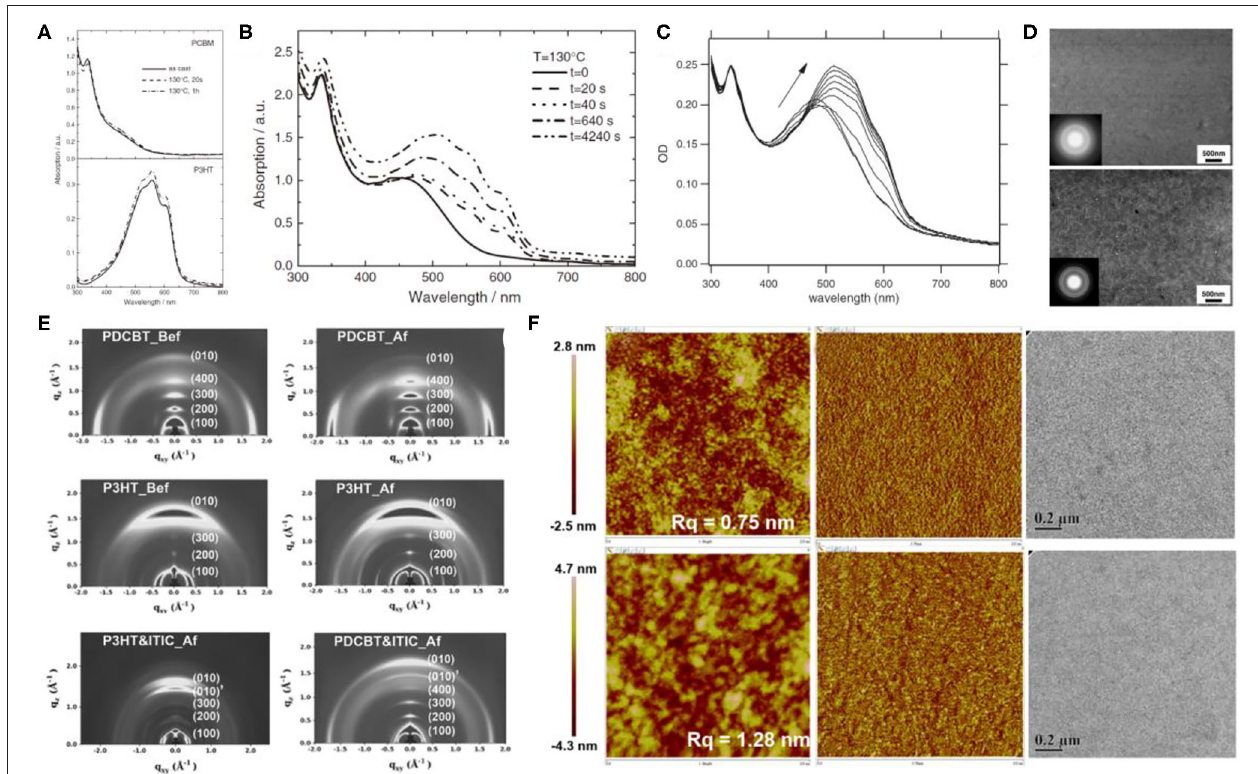
FIGURE 4 | (A) Absorption spectra of pure PCBM (top) and P3HT (bottom) films as cast (solid curves), annealed at TA = 130 ◦ C for t = 20s (dashed curves), and annealed for 1h, TA = 130 ◦ C (dotted curves). Copyright 2004, IOP Publishing Ltd. (B) Absorption spectra of a P3HT:PCBM composite film as cast (solid curve) and after four successive thermal annealing steps, as indicated in the legend. The PCBM concentration is 67%. Copyright 2004, IOP Publishing Ltd. (C) OD spectra of PCBM:P3HT blend films directly after spin-coating and at 40, 50, 55, 60, 70, 80, 90, 100 ◦ C for 5min. Arrow indicates rising temperatures. Copyright 2006, Elsevier B.V. (D) BF-TEM images of a 1:1 PCBM:P3HT pristine composite film (top) and after thermal annealing (bottom). The inserts are the corresponding selected area electron diffraction (SAED) patterns. Copyright 2006, Elsevier B.V. (E) 2D GIWAX images of the neat polymer and ITIC films. (Bef stands for before thermal